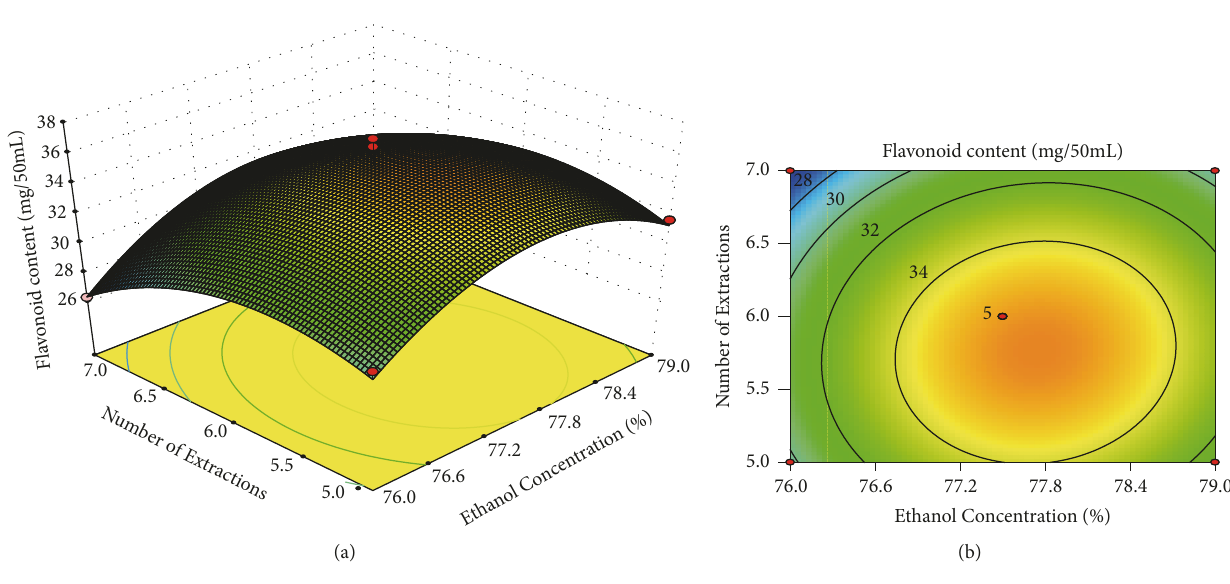
Figure 2: 3D response surface plots (a) and 2D contour plots